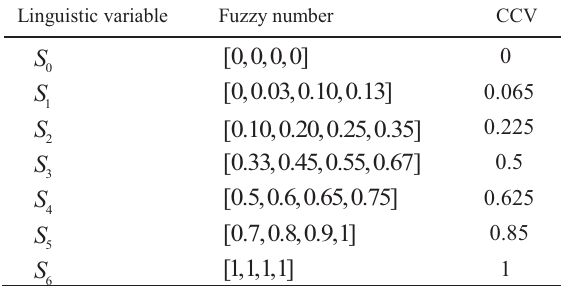
Table 6. The CCV and trapezoidal fuzzy numbers in [0,1]